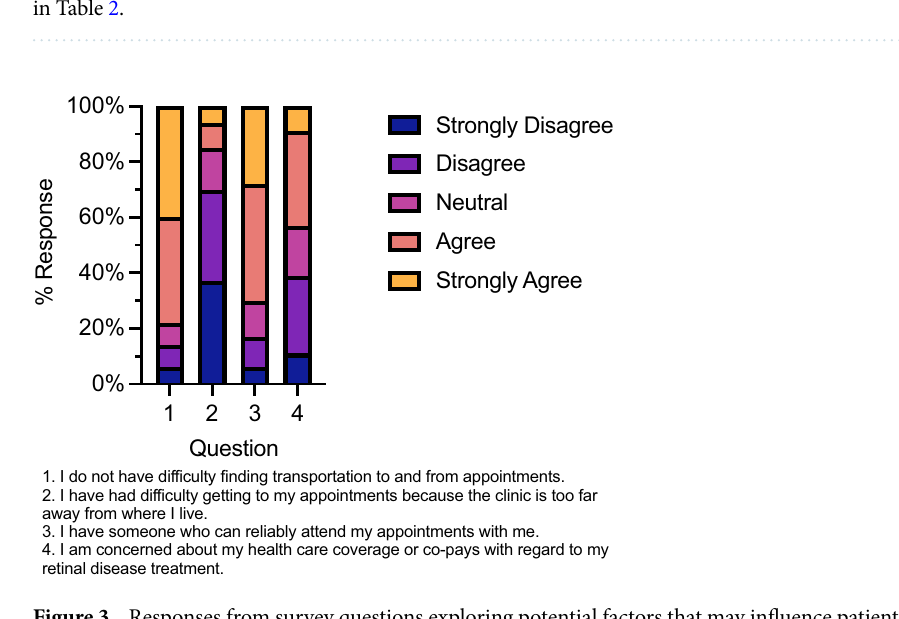
Figure 2. Opinions on preferred visit interval expressed as a histogram of survey responses. n = 53 responses as in Table 2.